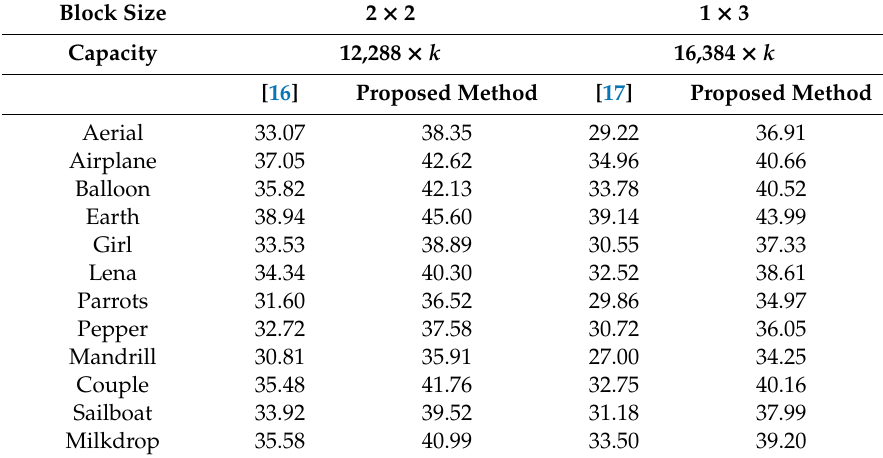
Table 5. PSNRs of Imaizumi et al.’s [16], Aryal et al.’s [17], and the proposed methods with k =